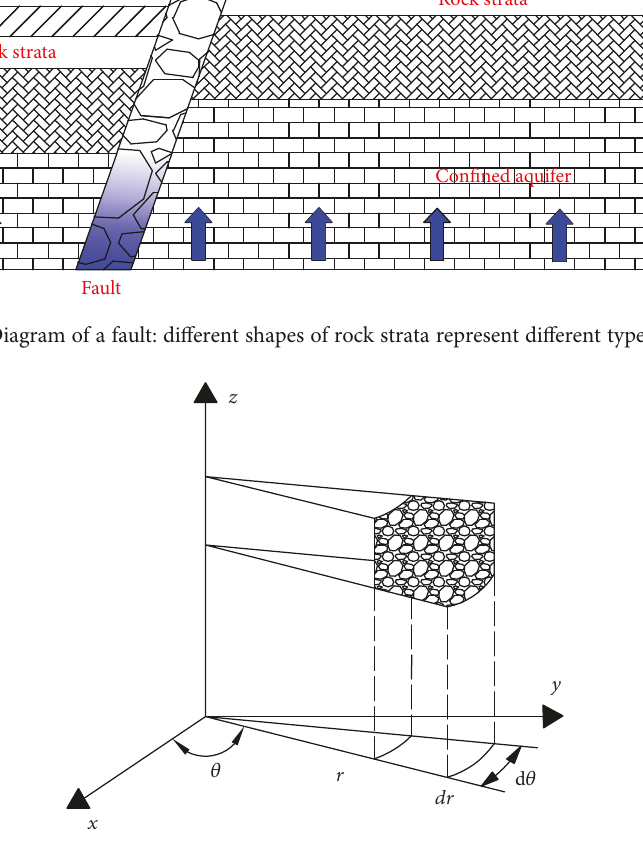
Figure 2: The representative element for faults in a cylindrical